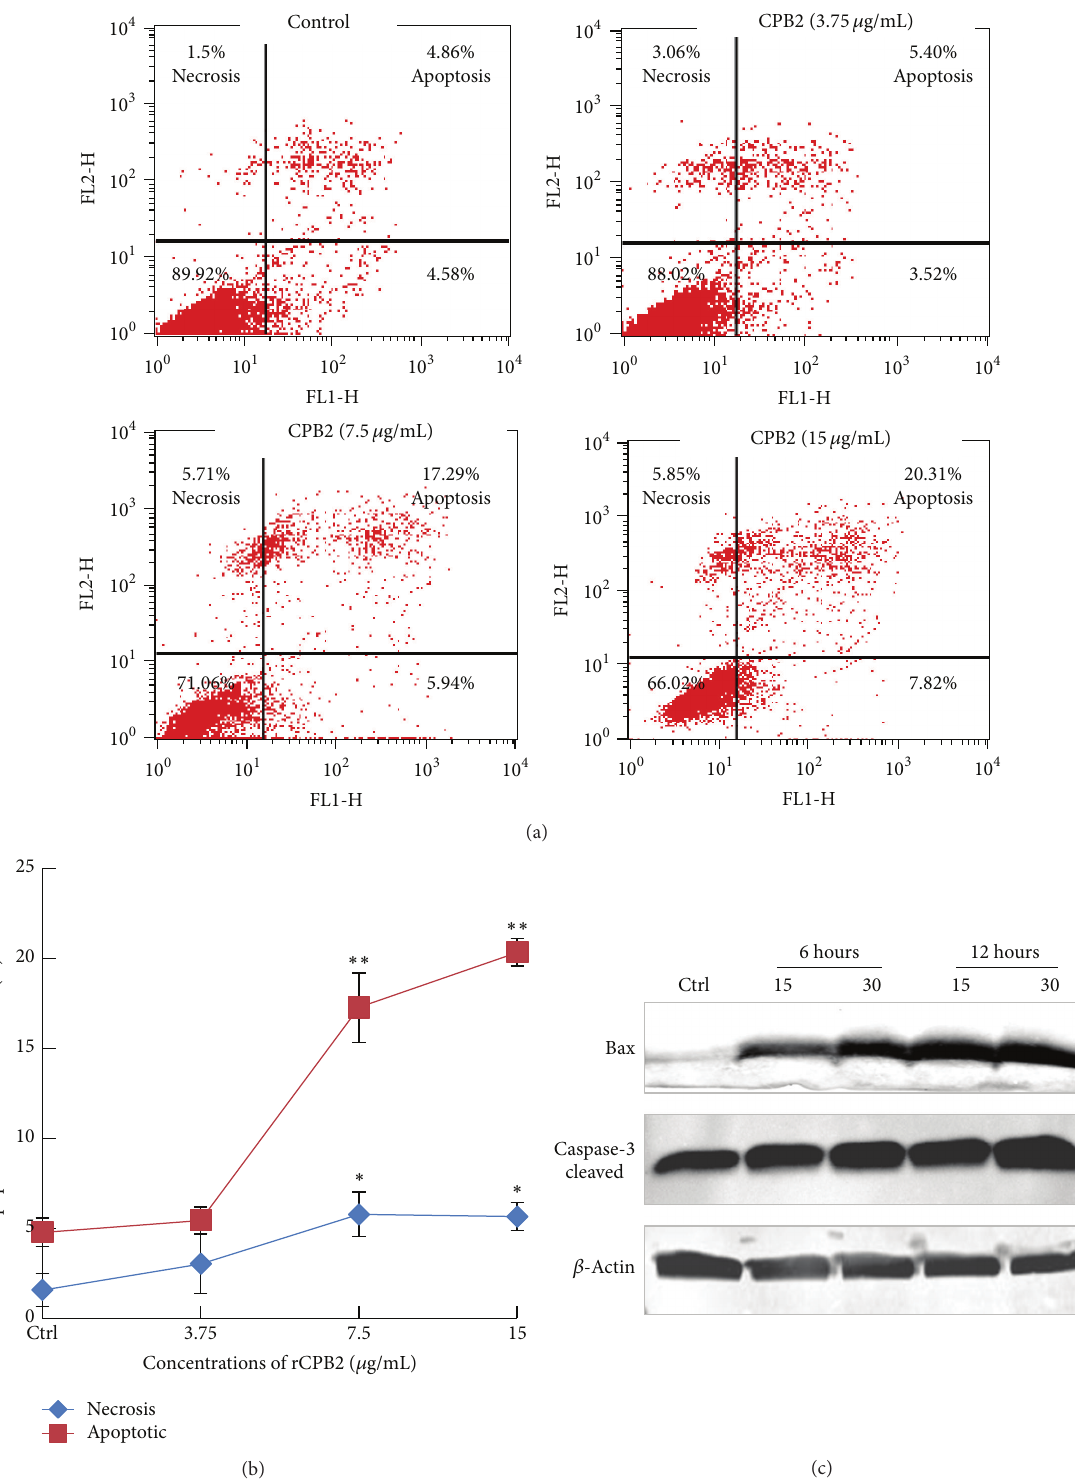
Figure 3: rCPB2 toxin induces apoptosis in NCM460 cells. The NCM460 cells were treated with indicated concentrations of rCPB2, and the cell death was analyzed by a cytometric assay. (a) Representative dot plots of three independent experiments of flow cytometry analysis showed an increased fraction of apoptotic NCM460 cells treated with indicated concentrations of rCPB2 for 12 h. (b) The quantitative analysis showed a dose-dependent cell apoptosis induced by rCPB2; the rCPB2 exhibited an ability to induce cell apoptotic death rather than necrosis. (c) Immunoblotting assay of proapoptotic protein caspase-3 and Bax showed potential of rCPB2-induced NCM460 cells. Data represented the mean ± SD from three independent experiments in (b) compared to a naive control, ∗ 𝑝 < 0.05 ; ∗∗ 𝑝 < 0.01